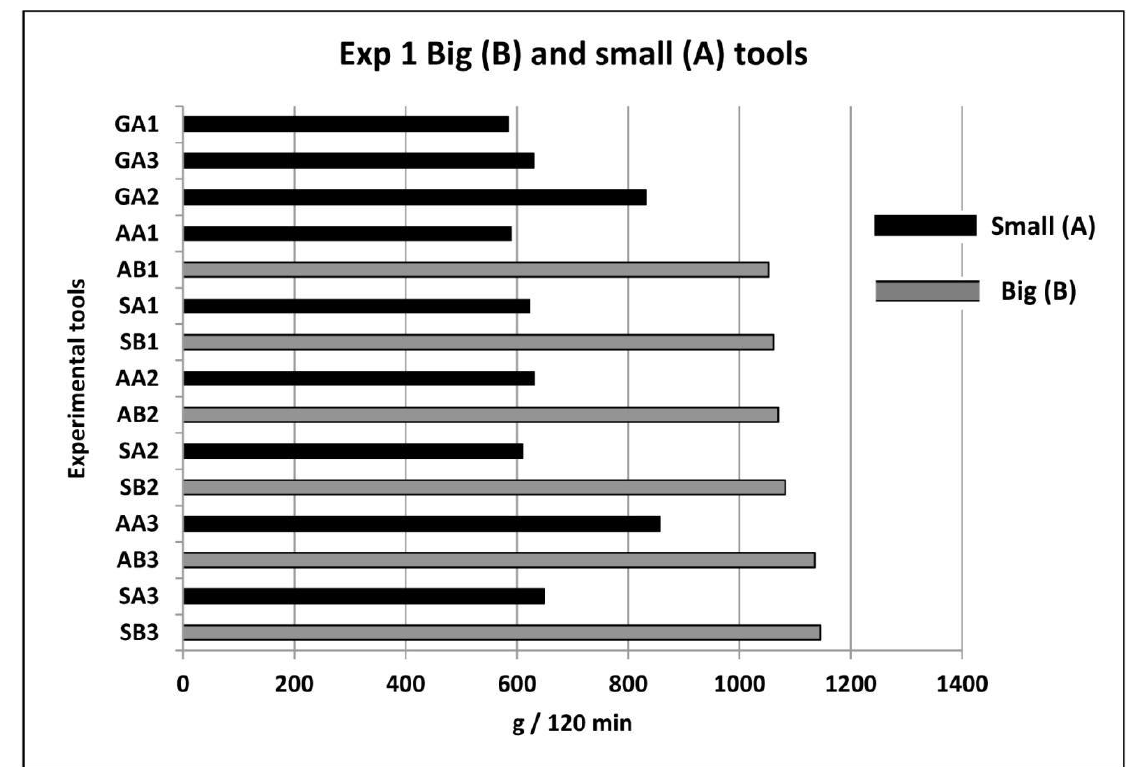
Figure 6. Experimental highest results of A tools (small) and B tools (big) in sequences of 120 min. Codes of grinding tools are in Table 1: A=andesite, S=sandstone,